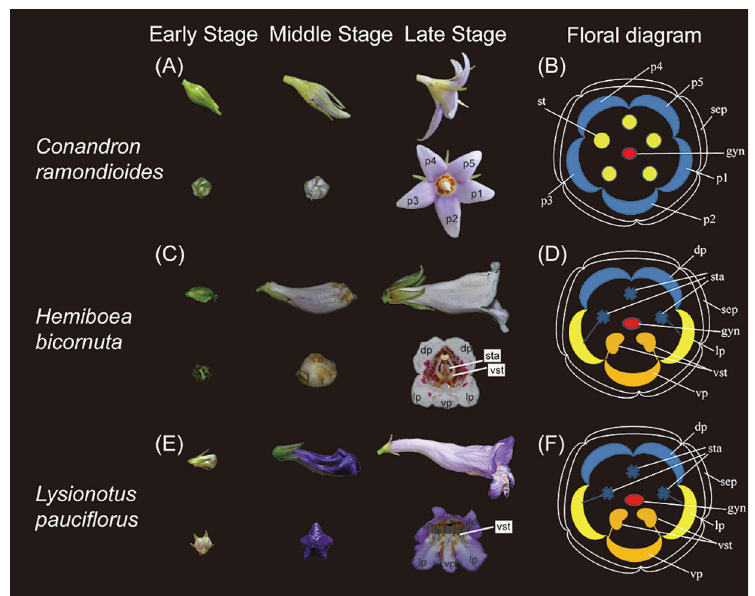
Fig 1. Flower morphology and developmental stages of Conandron ramondioides , Hemiboea bicornuta , and Lysionotus pauciflorus . (A) Three developmental stages (early, middle, and late) of C . ramondioides— Early Stage: petal length < sepal length; Middle Stage: petal length > sepal length; Late Stage: flower at anthesis. (B) Floral diagram: Five sepals (sep, black); five petals (from p1 to p5, blue); five stamens (st, yellow); gynoecium (gyn, red). (C) Three developmental stages of H . bicornuta— Early Stage: petal length < sepal length; Middle Stage: petal length > sepal size; Late Stage: flower at anthesis. (D) Floral diagram: sepals (sep, black); dorsal petals (dp, blue); lateral petals (lp, yellow); ventral petal (vp, orange); staminodes (sta, blue); ventral stamens (vst, orange); gynoecium (gyn, light blue). (E) Three development stages of L . pauciflorus— Early Stage: petal length < sepal length; Middle Stage: petal length > sepal size; Late Stage: flower at anthesis. (F) Floral diagram: sepals (sep, black); dorsal petals (dp, blue); lateral petals (lp, yellow); ventral petal (vp, orange); staminodes (sta, blue); ventral stamens (vst, orange); gynoecium (gyn, light blue).